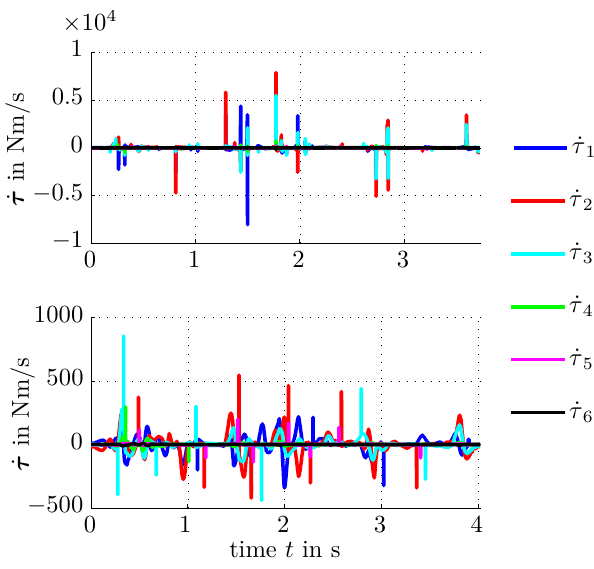
Figure 10. Motor torque rates, above: torque rate trends for the SDP solution, below: torque rate trends for the smooth